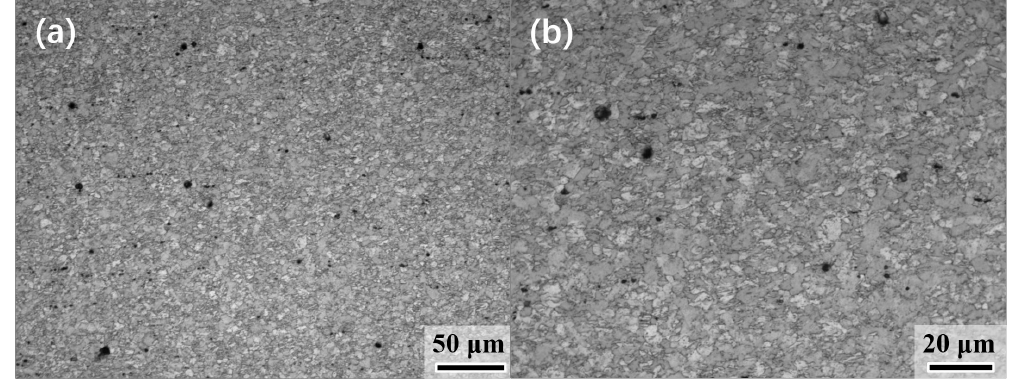
Figure 5. ( a ) Low power and ( b ) high power LM micrographs of the E-CRed BX11